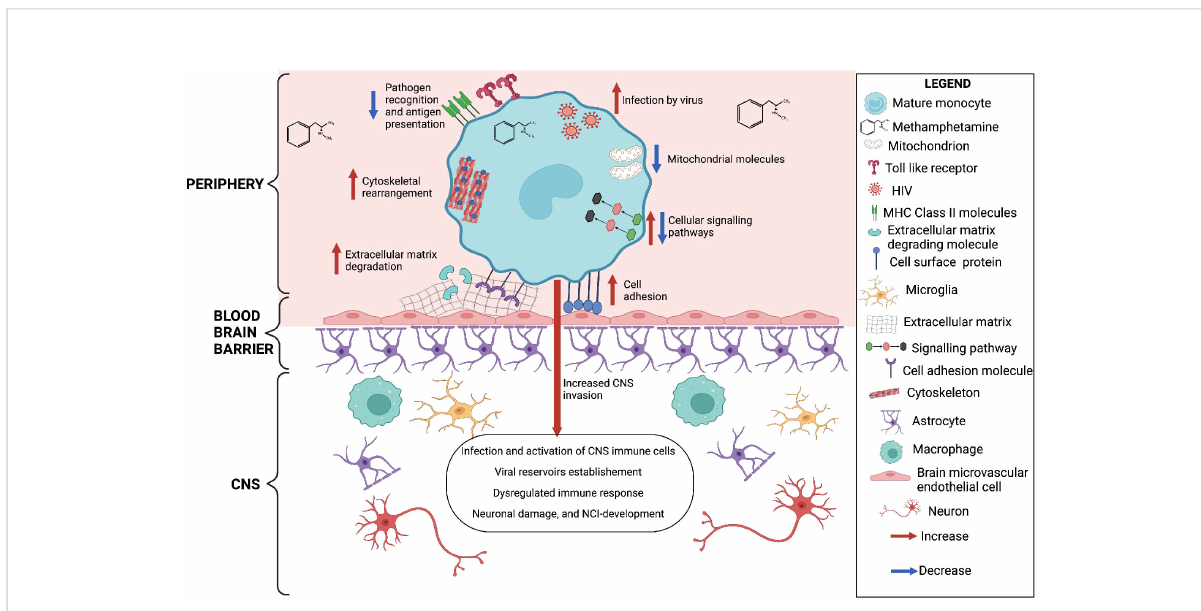
FIGURE 6 Meth-mediated effects on HIV-infected mature monocytes as identi fi ed by RNA sequencing and western blot analyses. Figure created with